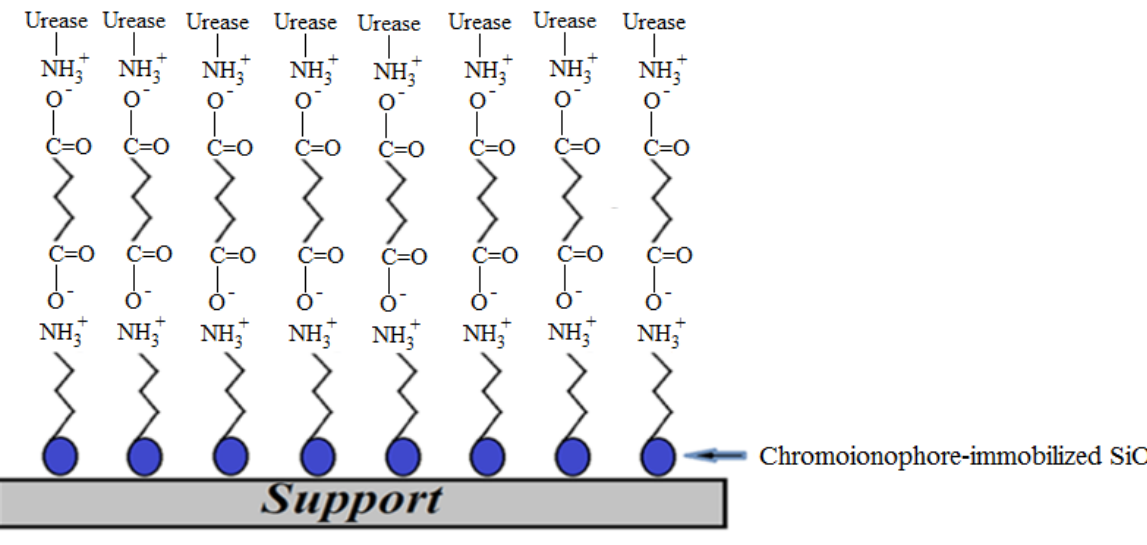
NPs-based optical urea 2